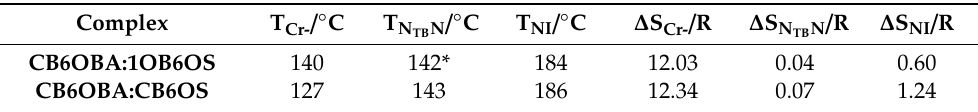
Table 3. Transition temperatures and associated entropy changes for the supramolecular trimers